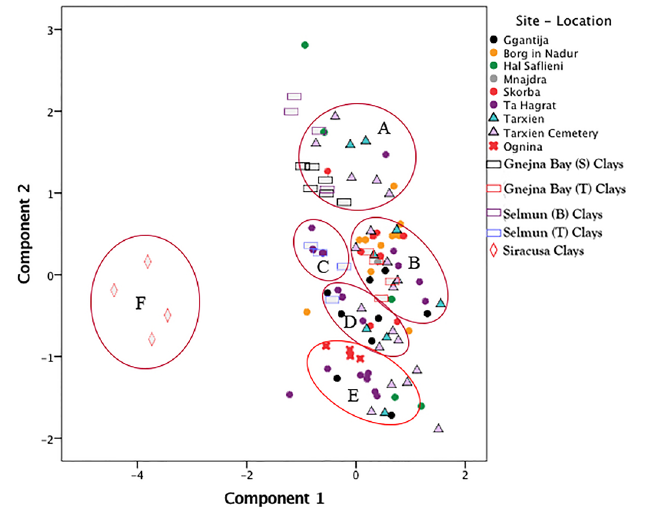
Figure 5. Bivariate scatterplots of principal component scores for Tarxien Cemetery phase samples and Maltese and Sicilian clay samples. Ellipses are made